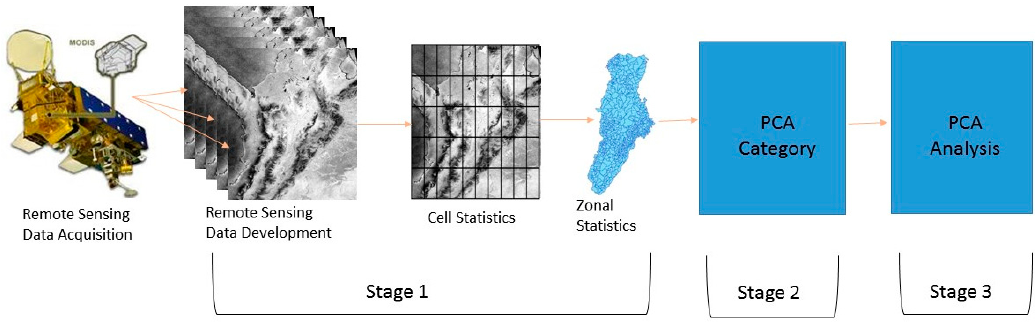
Figure 2. Graphic depicting stages of analysis.